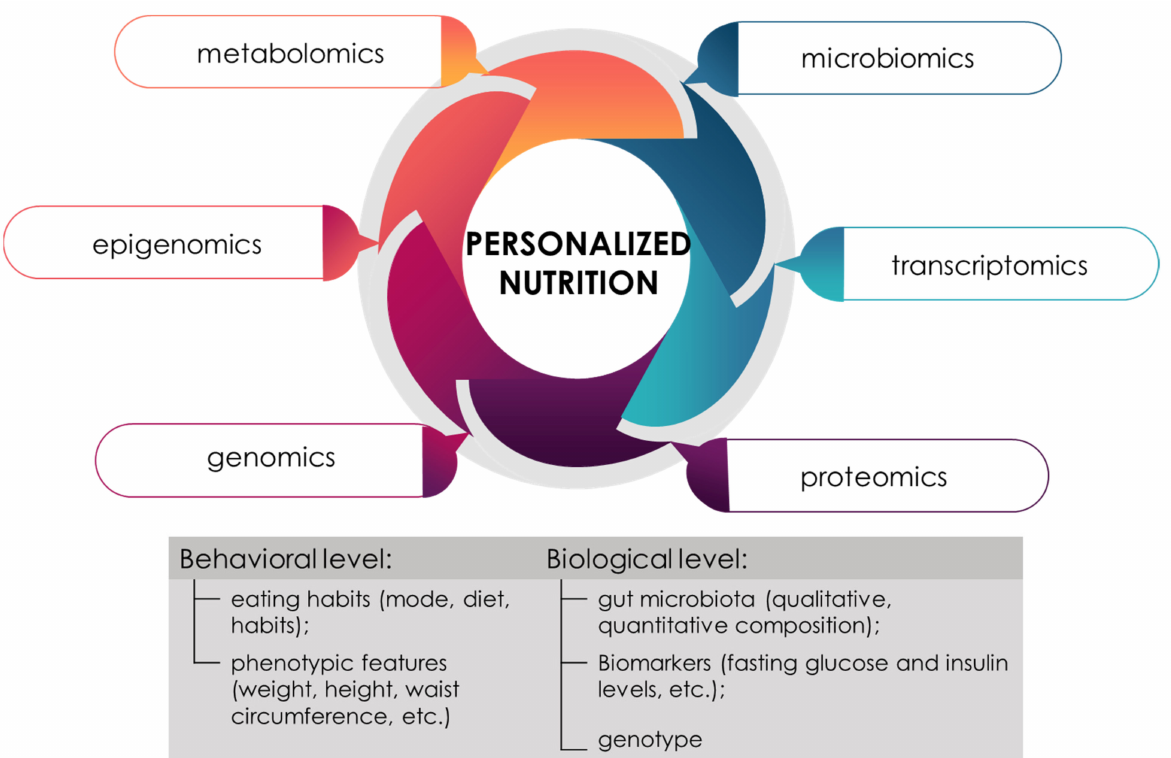
Figure 2. The importance of the influence of «omics» technology and the search for characteristics, the assessment of which is necessary for the formation of a personalized approach to